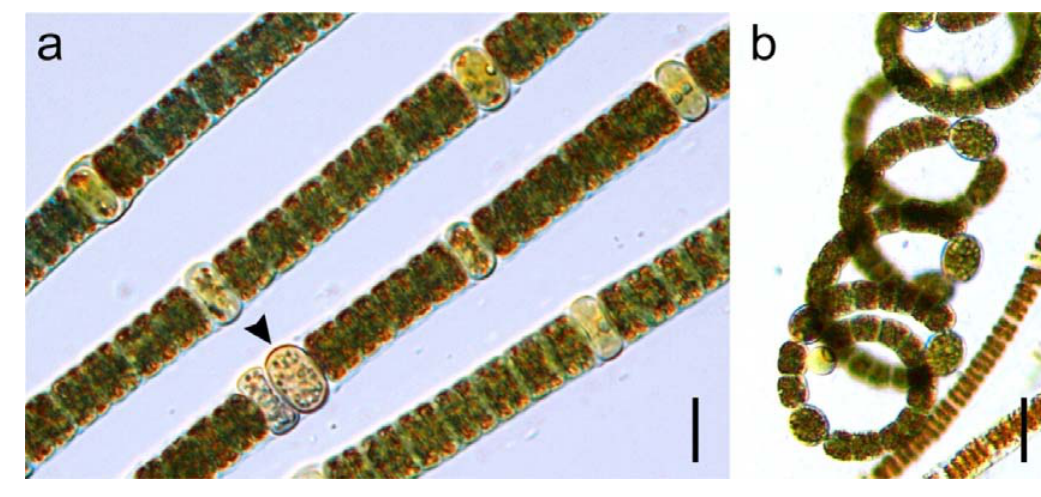
Figure 1. ( a ) Nodularia spumigena , arrow indicates akinetes (scale bar 10 µm); ( b ) Anabaenopsis arnoldii (scale bar 15